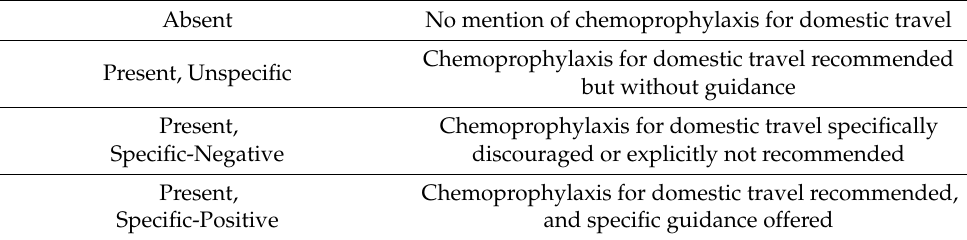
Table 2. Classification of chemoprophylaxis recommendations in MPTGs